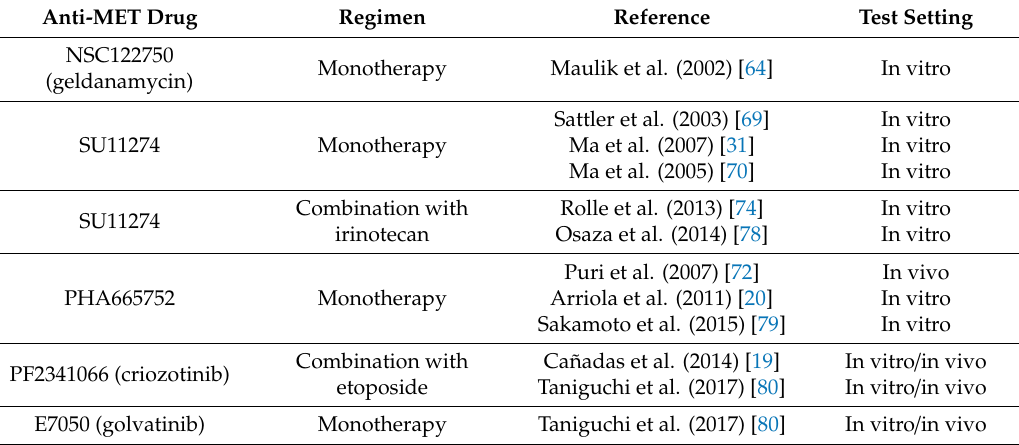
Table 1. Preclinical testing of anti-MET targeted therapy in